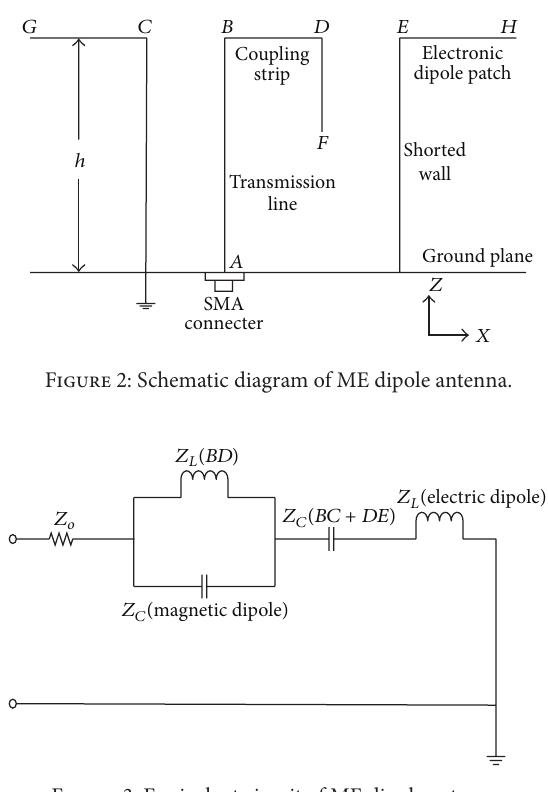
show inductive while magnetic dipole, vertical portions of feeding structure, and shorted wall chiefly display